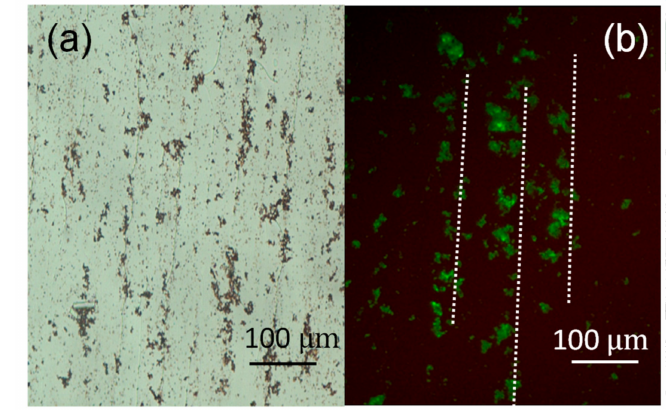
Figure 2. Polarizing optical microscopy (POM) images in the nematic phase of CsLC at 30 ◦ C captured with ( a ) white light and ( b ) excitation light obtained from a 404 nm laser. The linear assembly of QCs along the director direction n is seen as dark objects on the grey nematic background for white light and bright green regions for 404 nm excitation. The influence of LC birefringence was avoided by removing the